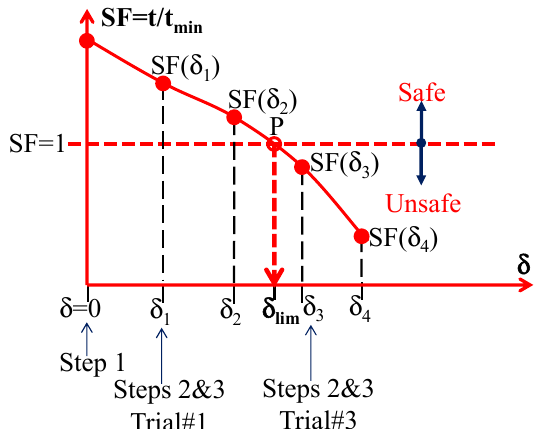
Figure 5. Safety factor ( SF ) versus the horizontal settlement ( δ ) imposed at the right constraint of the arch.